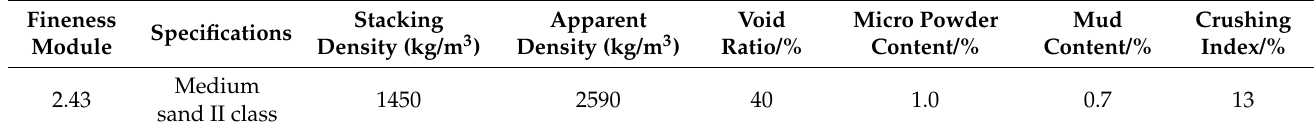
Table 2. Performance index of natural fine aggregate.